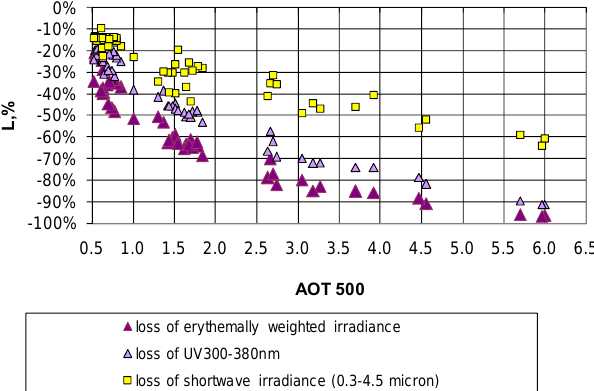
Fig. 10. The losses ( L , %) of erythemally-weighted UV irradi- ance, UV irradiance 300–380nm (UV300–380nm), and shortwave Fig.10. The losses (L, %) of erythemally-weighted UV irradiance, UV irradiance irradiance (0.3–4.5µm) as a function of aerosol optical thickness 300-380nm (UV300-380nm), and shortwave irradiance (300- 4500 nm) as a function of aerosol optical thickness at 500nm (AOT500) during the fire event in 2010. at 500nm (AOT500) during the fire event in 2010. Meteorological Observatory of Moscow State University.